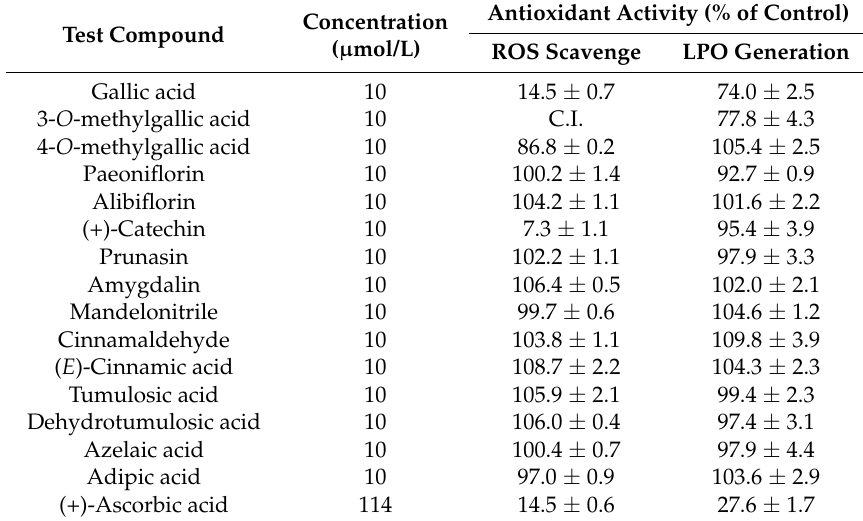
Table 3. Antioxidant activity of blood-absorbed KBGY constituents and their metabolites.